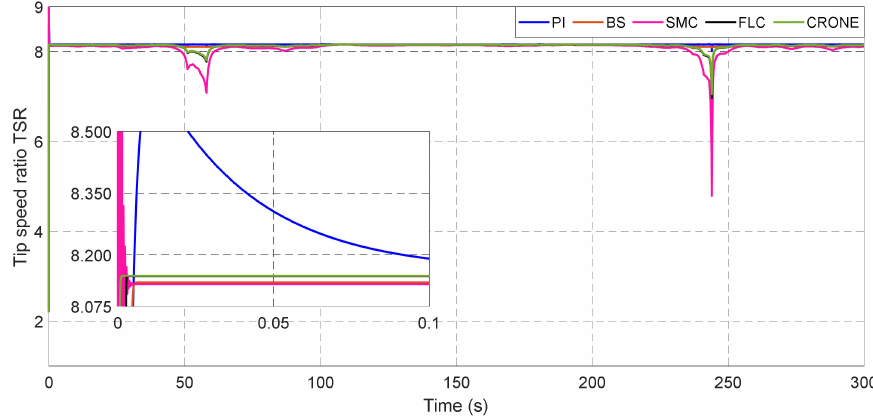
Figure 18. Tip speed ratio for PI, BS, SMC, FLC, and CRONE controllers.